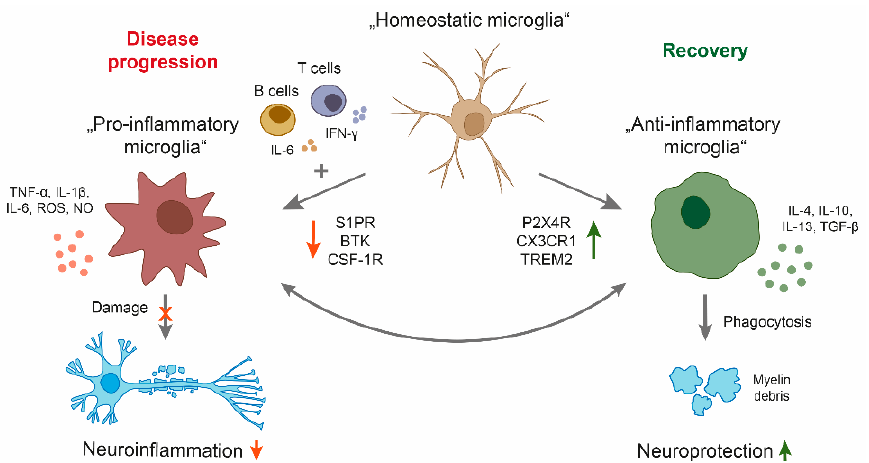
Figure 1. Schematic overview of microglia polarization in multiple sclerosis (MS). During disease progression, a central nervous system (CNS) compartmentalized milieu generated by pro-inflammatory B and T cells as well as CNS resident cells leads to a reactive phenotype of microglia with neuroinflammatory properties. By secreting cytokines and upregulation of particular cell surface molecules, the phenotype triggers oligodendrocyte damage, resulting in demyelination, axonal damage, and neuronal loss. On the other side, microglia have important physiological functions in maintaining tissue homeostasis, including clearance of debris, resulting in neuroprotection. Candidate drugs for treatment of MS progression may either inhibit pro-inflammatory (S1P, BTK, CSF-1R) or enhance anti-inflammatory properties of microglia (P2X4R, CX3CR1, TREM2). BTK: Bruton’s tyrosine kinase, CSF-1R: colony-stimulating factor 1 receptor, CX3CR1: CX3 chemokine receptor 1, IFN γ : Interferon- γ , IL: interleukin, NO: nitric oxide, P2X4R: purinergic receptor P2X4, ROS: reactive oxygen species, S1PR: sphingosine-1-phosphate receptor, TGF: transforming growth factor, TNF: tumor necrosis factor, TREM2: triggering receptor expressed on myeloid